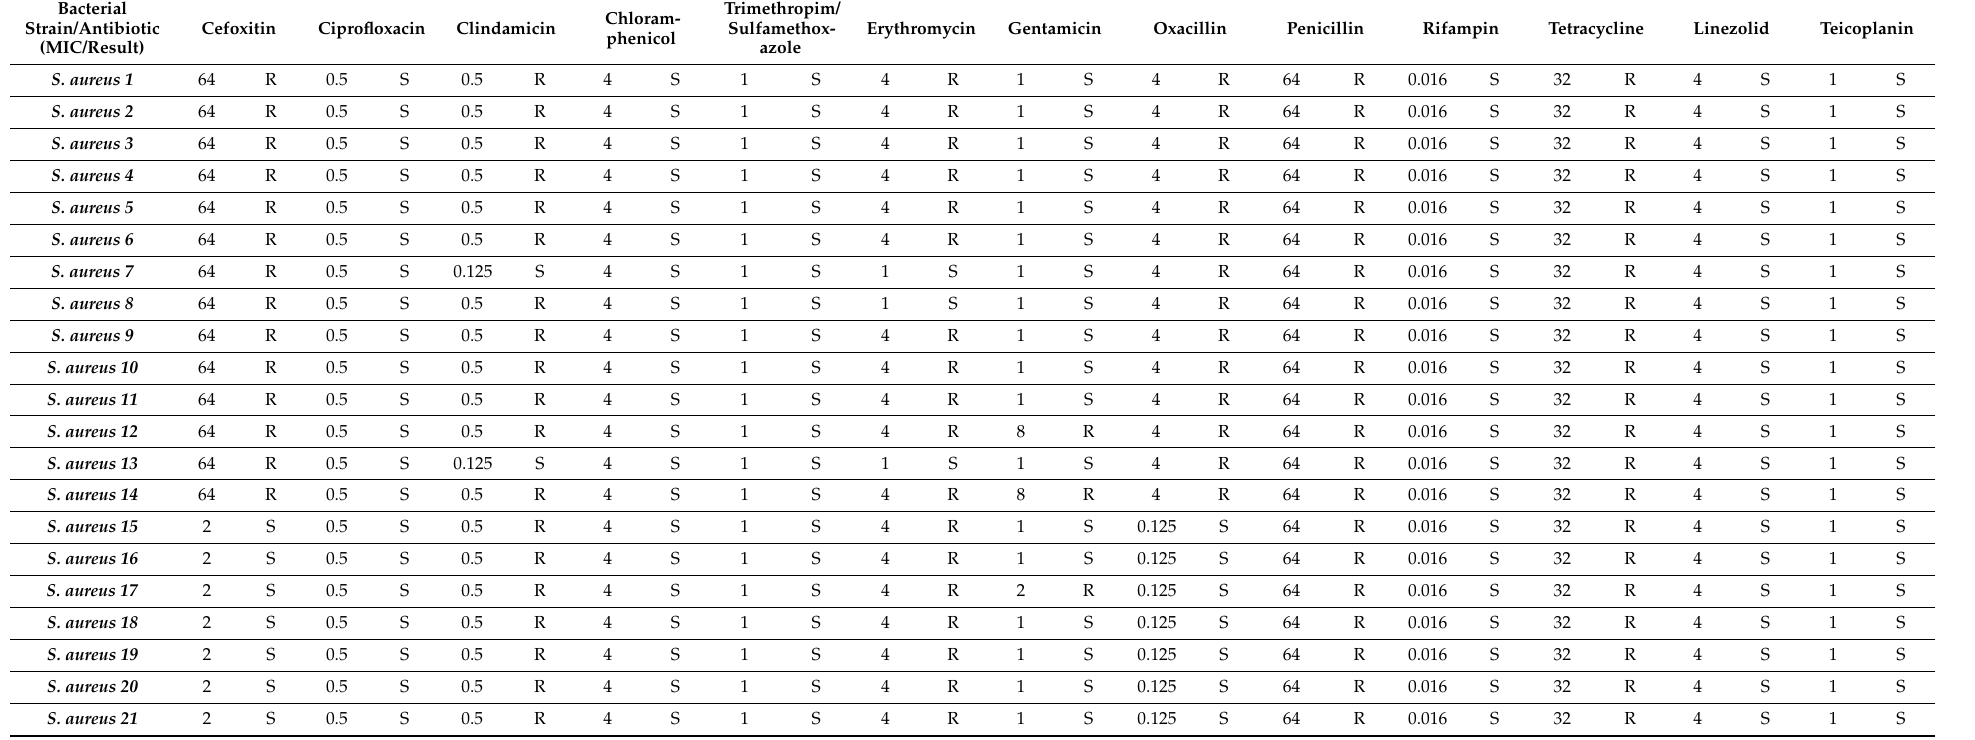
Table 5. MICs (mg/L) of antimicrobials for Staphylococcus aureus isolates.